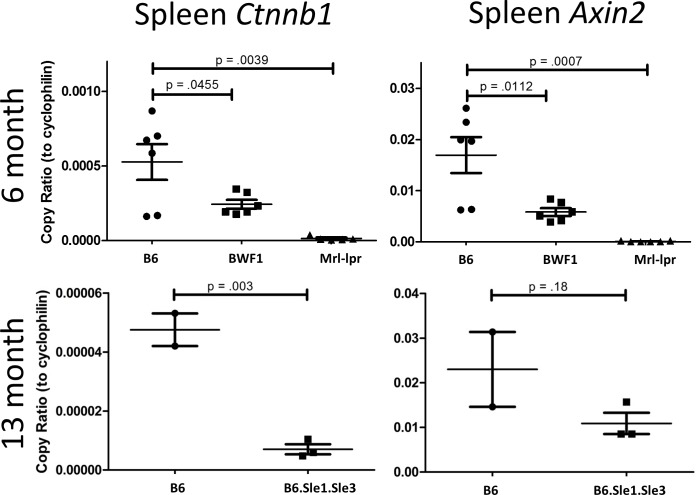
Splenocytes from multiple, genetically diverse lupus-prone strains express lower levels of β-catenin target transcripts.Splenocytes from 6-month and 13-month healthy B6 and lupus-prone Mrl-lpr, BWF1, and B6.Sle1.Sle3 mice were isolated and probed for Ctnnb1 and Axin2 transcripts by RT-PCR. Lupus-prone mice exhibit a loss of β-catenin-related transcription versus healthy age-matched B6 controls.